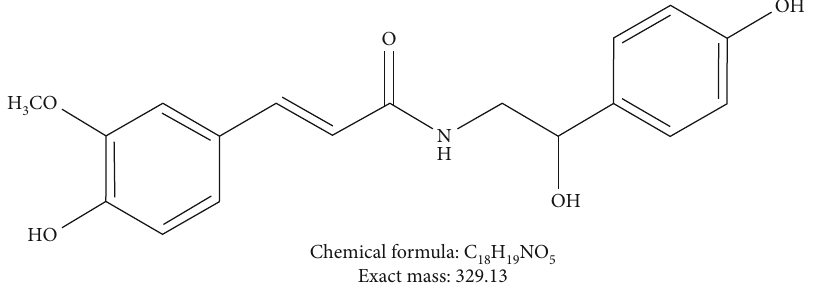
Figure 1: Molecular structure, chemical formula, and molecular weight of